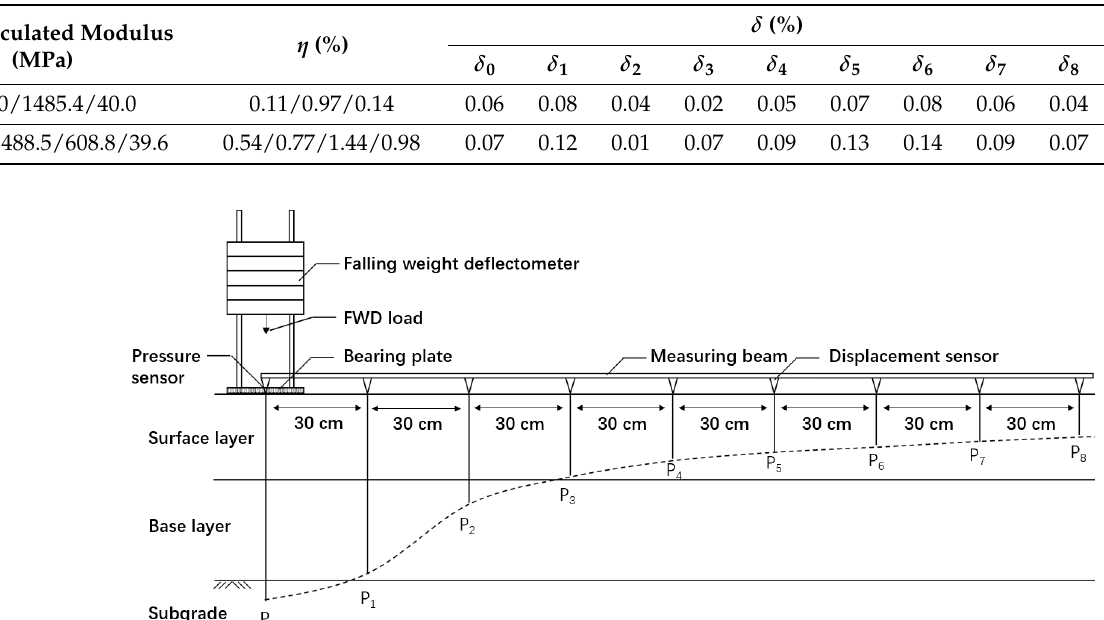
Table 4. The modulus back calculation accuracy.